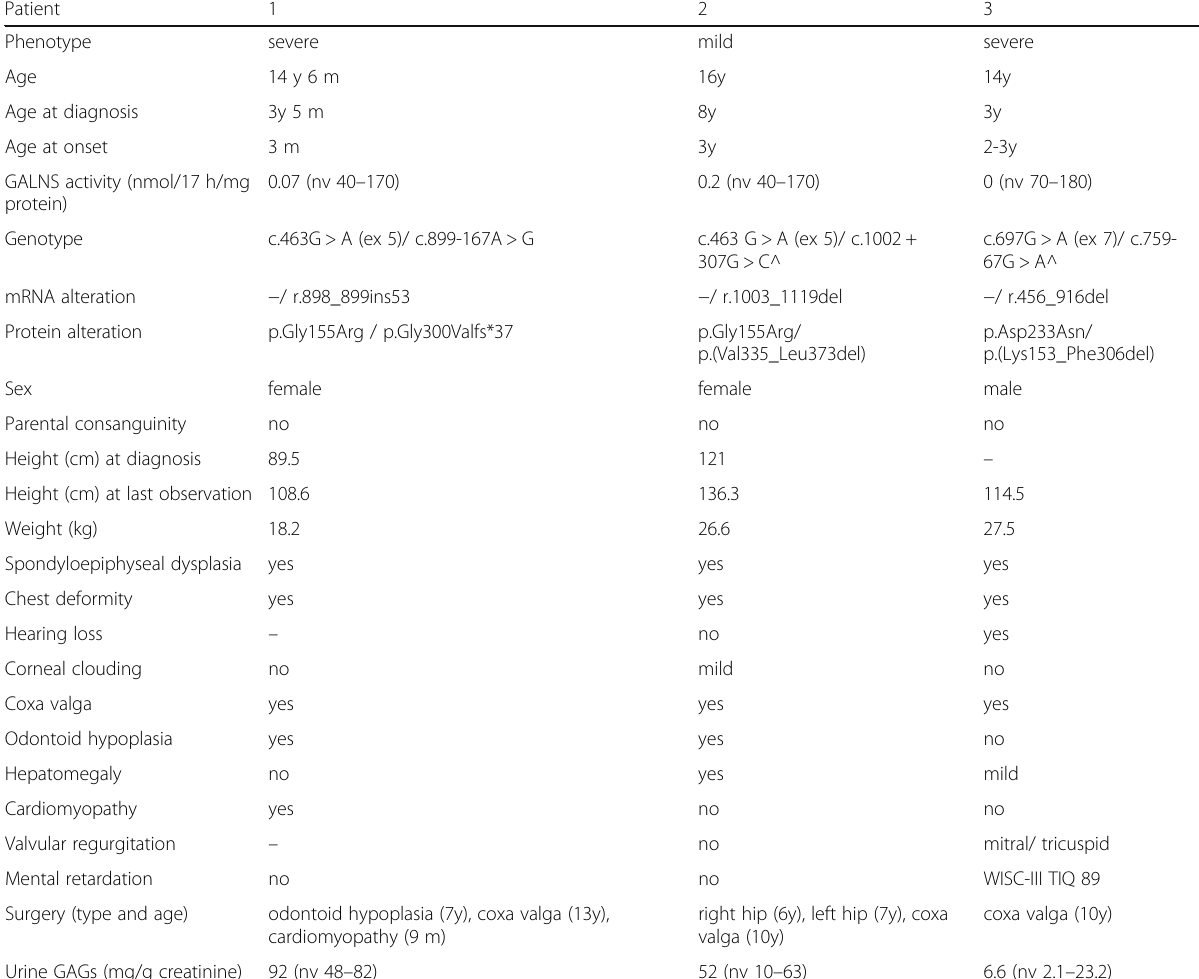
Table 1 Clinical biochemical and molecular features of MPSIVA patients